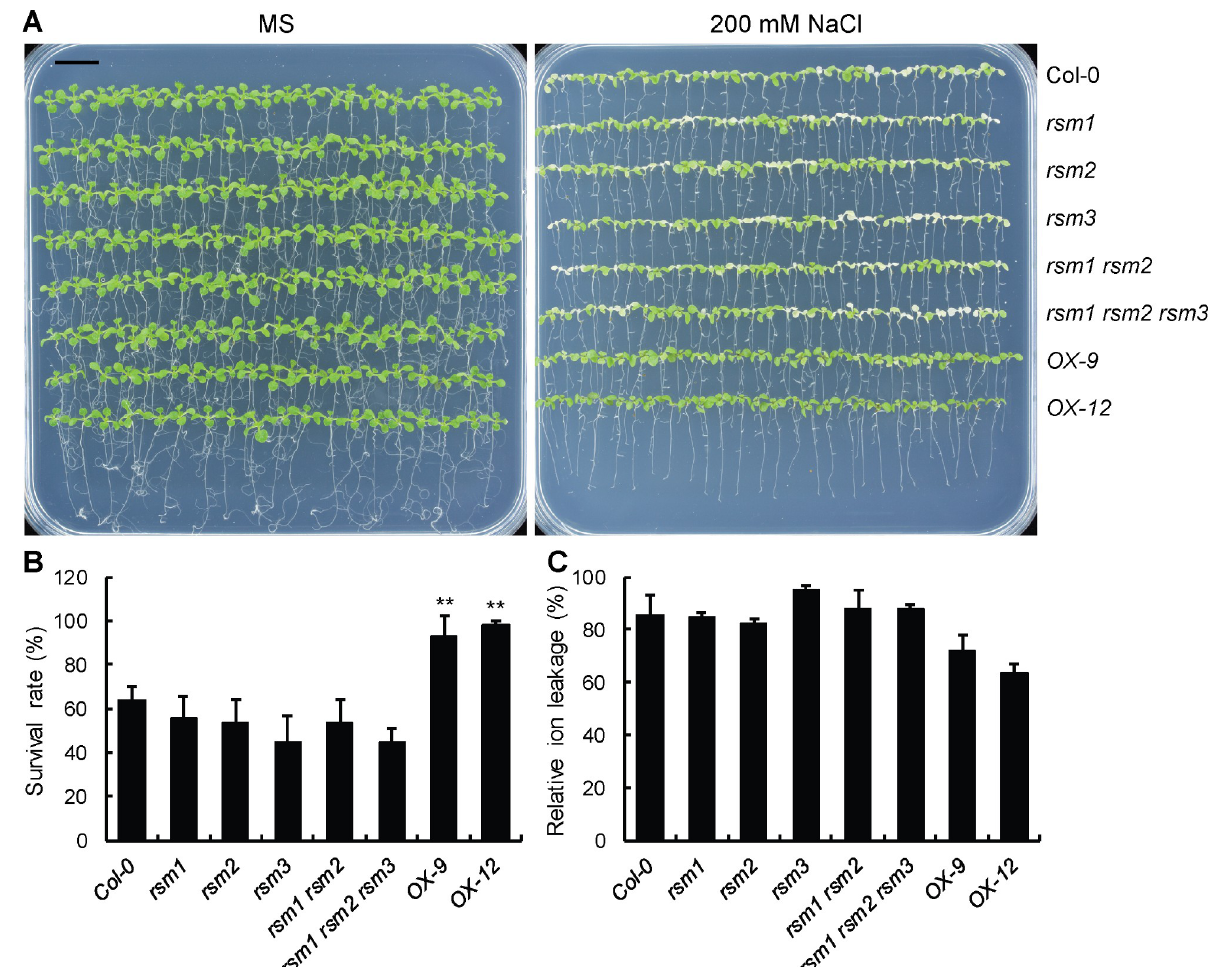
Fig 3. RSM1 overexpression causes hyposensitivity to salinity during seedling development. (A) Overexpression of RSM1 enhances salt tolerance. Plants were grown on MS medium for 7 days and transferred to MS medium with or without 200 mM NaCl for 3–4 days, after which they were photographed. The images are representative of at least three experimental replicates. The scale bar indicates 1 cm. (B) Survival rates of RSM1 -related materials as illustrated in (A). The survival rates were determined by scoring and calculating the ratio of the number of bleached seedlings to the total number of seedlings. The data are shown as the mean ± SD of three independent replicates of measurements (n = 3), where each genotype replicate included approximately 25 seedlings. �� indicates p < 0.01 for the significance of the difference between each genotype and Col-0. (C) Relative ion leakage of RSM1 -related seedlings as shown in (A). The data are shown as the mean ± SD from three replicates, each of which included approximately 50 seedlings (n = 3).